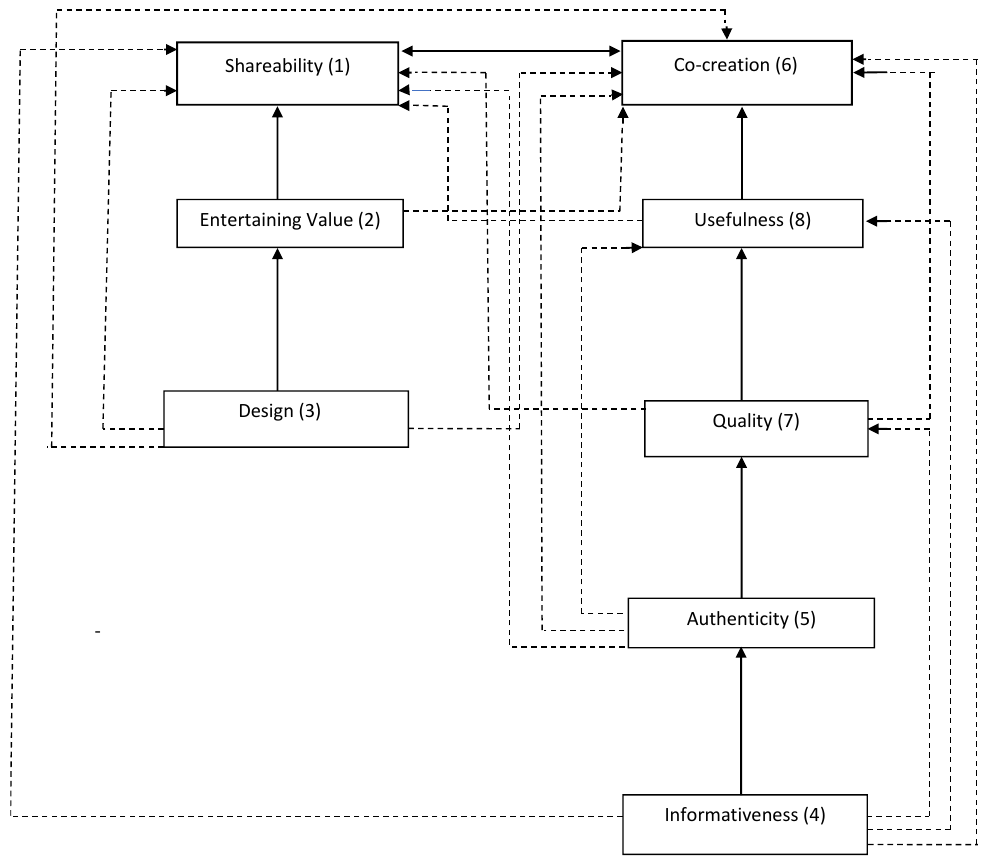
Figure 2. TISM Model (Digraph).